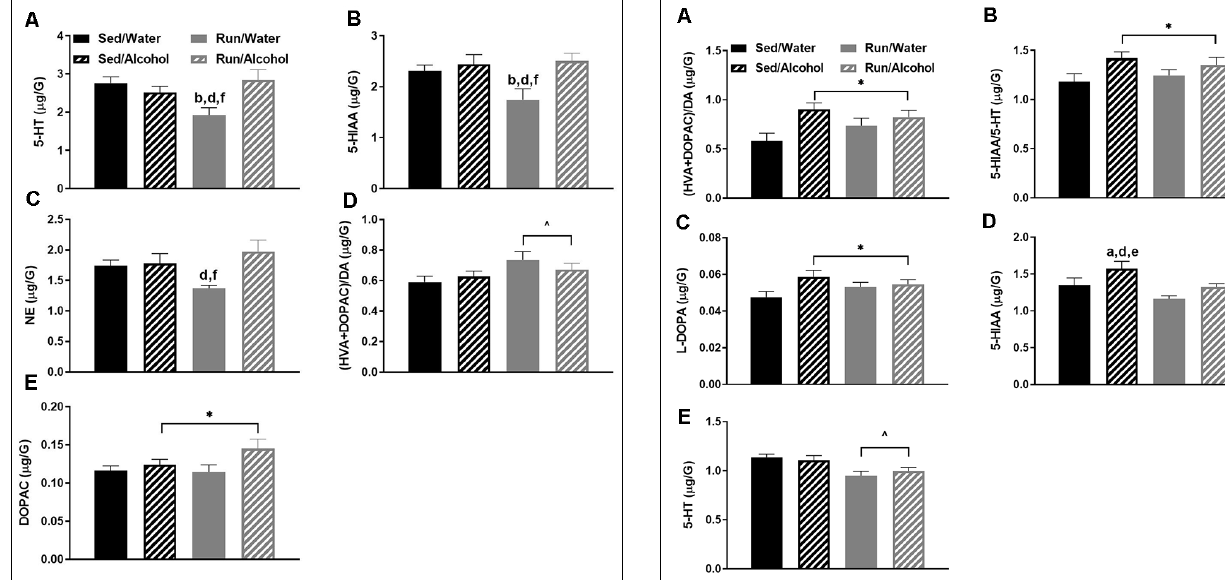
FIGURE 5 | Neurochemical levels in the mouse brainstem area immediately following the final DID session. The ratio of (HVA + DOPAC)/DA (A) , the ratio of 5-HIAA/5-HT (B) , L-DOPA concentrations (C) , 5-HIAA concentrations (D) , and 5-HT concentrations (E) . Data represent means +SEM. ∗ P < 0.05 main effect alcohol access, ∧ P < 0.05 main effect physical activity status, a P < 0.05 Sed/Water from Sed/Alcohol, d P < 0.05 Sed/Alcohol from Run/Water, e P < 0.05 Sed/Alcohol from Run/Alcohol. Figure 5C ). Physical activity status ( F (1,32) = 7.82, p = 0.0087) and ethanol access ( F (1,32) = 6.27, p = 0.0176)